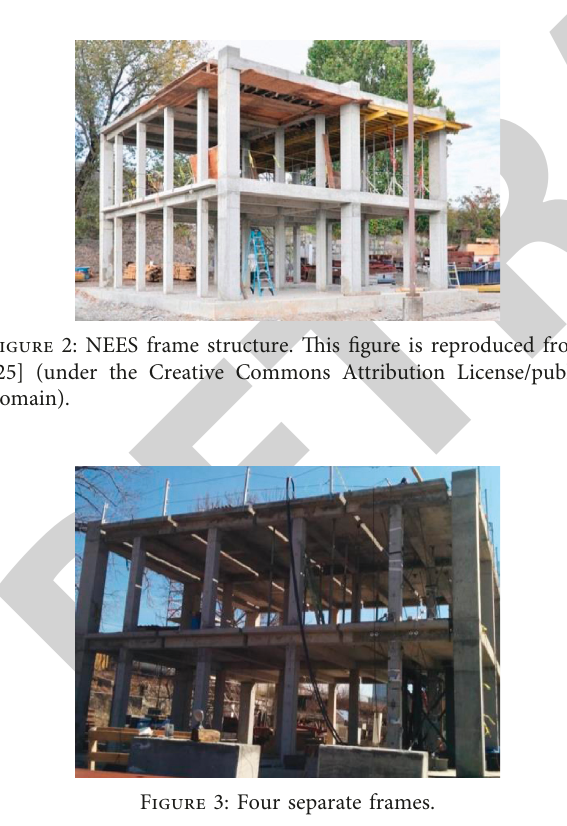
Figure 1: Bidimensional and three-dimensional PLSs. This figure is reproduced from [25] (under the Creative Commons Attribution License/public domain).